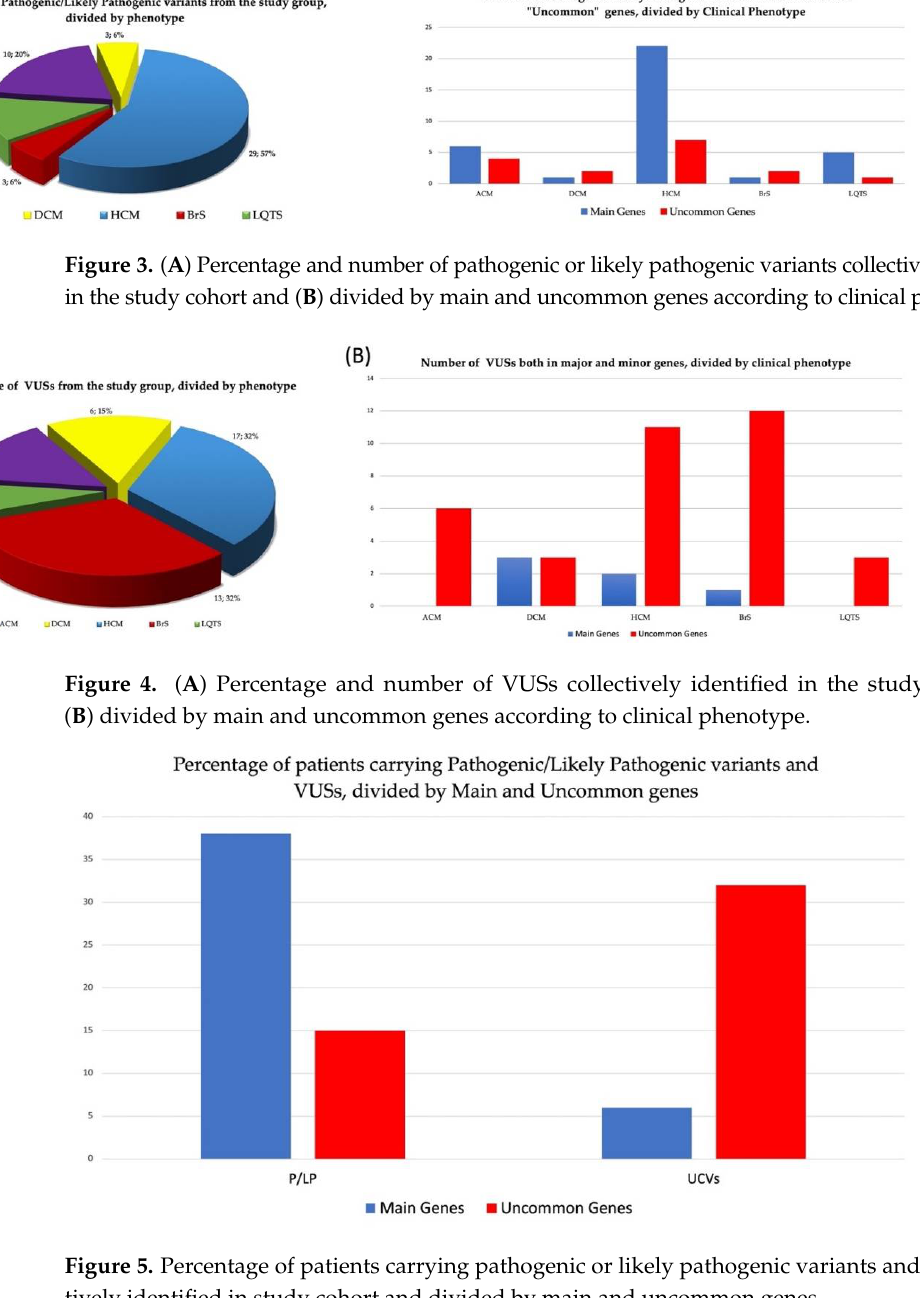
Figure 5. Percentage of patients carrying pathogenic or likely pathogenic variants and VUSs collectively identified in study cohort and divided by main and uncommon genes.